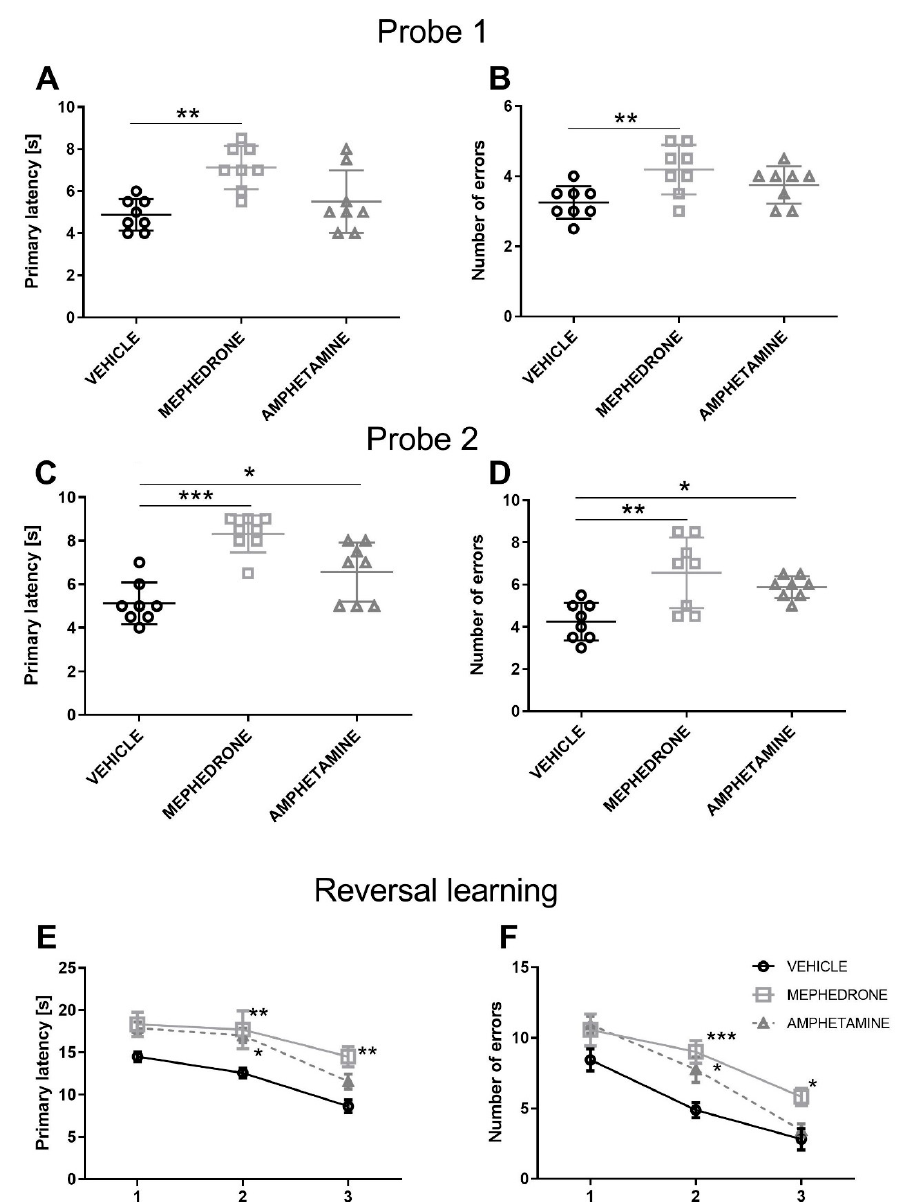
Figure 3. Effect of repeated mephedrone or amphetamine administration on ( A ) primary latency and ( B ) number of errors committed in the probe trial (Probe 1) of the Barnes maze task (PND 71); ( C ) primary latency and ( D ) number of errors committed in the probe trial (Probe 2) (PND 84); ( E ) primary latency and ( F ) number of errors committed during 3 days of the reversal learning phase of the Barnes maze task (PND 85–87). Data are expressed as the mean ± SEM. n = 8 rats/group. * p < 0.05, ** p < 0.01, *** p < 0.001 vs. vehicle (0.9% NaCl).